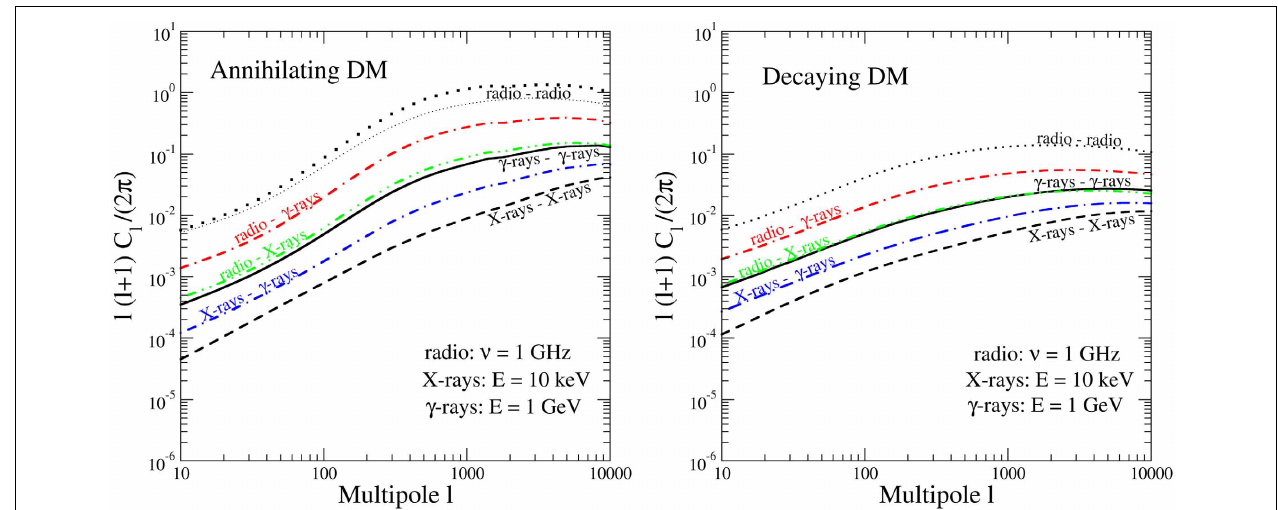
FIGURE 4 | Angular PS of radio, X-ray, and gamma-ray emissions (auto- andcross-correlations)fromannihilatingDM(leftpanel)anddecayingDM (right panel). The computation is performed using the 3D PS models reported